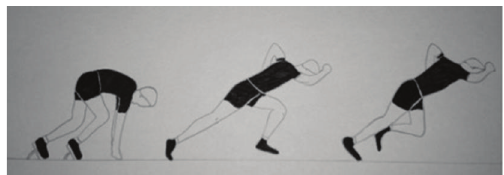
Figure 3: Propulsion at the exit of starting block. Hip extension and maximum knee extension, combined with a slight rotation of the trunk, corresponding to a traction on sartorius and fascia lata associated with a traction on abdominal muscle explaining the large